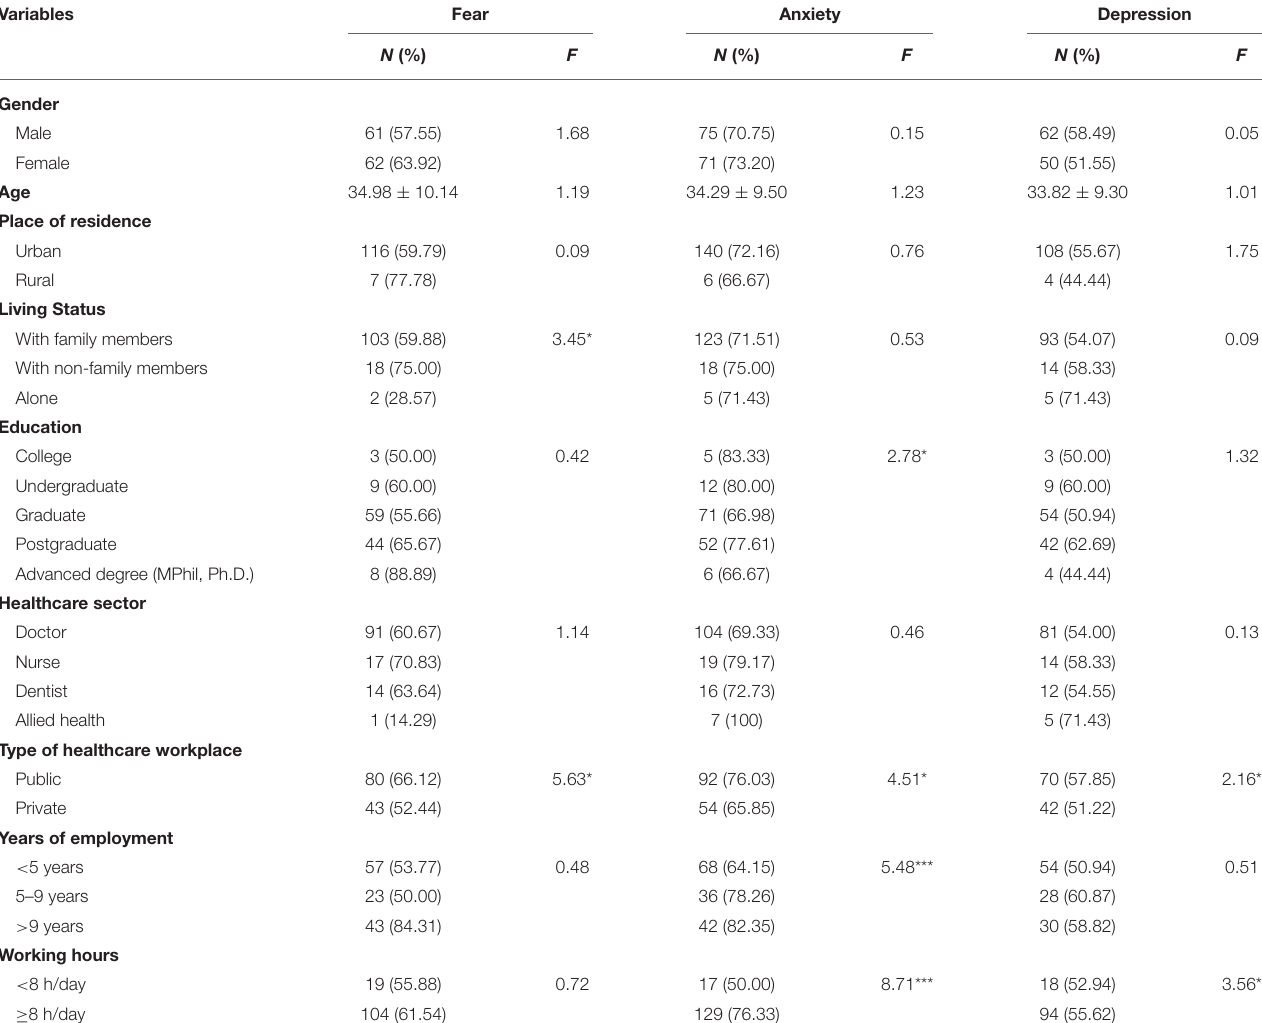
TABLE 3 | Univariate analysis of risk factors associated with psychological disorder among Bangladeshi healthcare workers during the early stages of the COVID-19 pandemic ( N = 203). Variables Fear Anxiety Depression N (%)